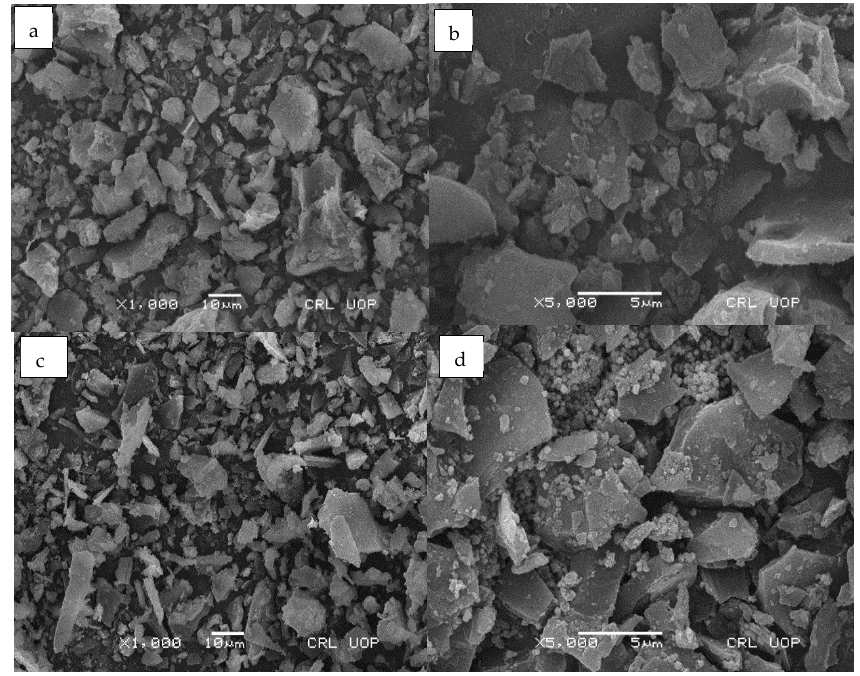
Figure 3. SEM micrograph of IBC at the magnification of ( a ) 10 µm ( b ) 5 µm and MgO-IBC composite at ( c ) 10 µm ( d ) 5 µm.